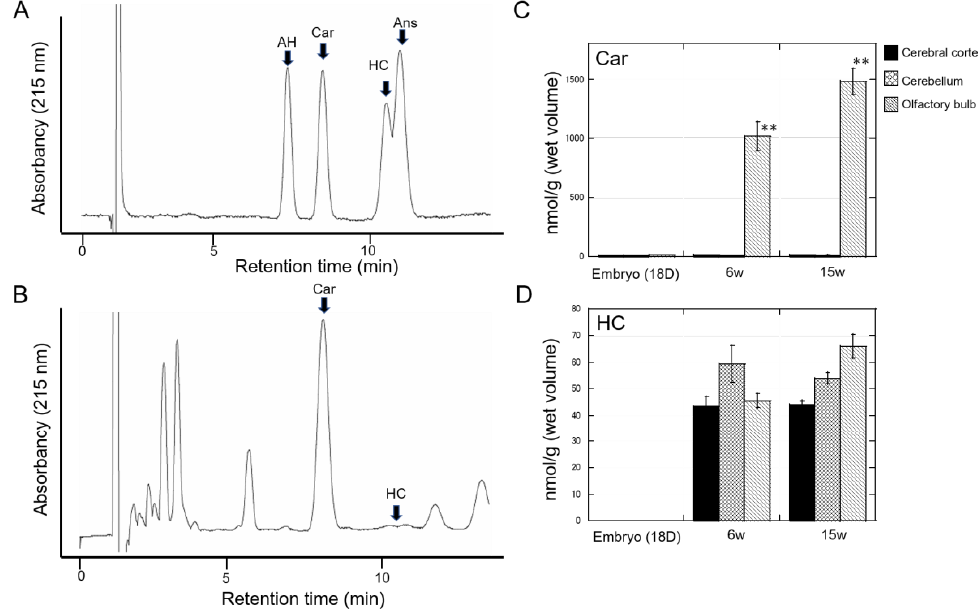
Figure 4. Developmental changes in carnosine and related compounds in the brain. Each brain region (cerebrum, cerebellum, and olfactory bulb) was dissected from Wistar rats, homogenized and heated at 95 °C for 15 min. After centrifugation, the supernatant was analyzed by HPLC equipped with a Hypercarb TM column (Thermo Fisher Science, Waltham, MA, USA). Carnosine (Car), homocarnosine (HC), alanyl histidine (AH), and anserine (Ans) were analyzed using an isocratic elution of 7% acetonitrile in the presence of 0.1% trifluoroacetic acid at a flow rate of 1 mL/min and monitored with UV at 215 nm. Data are expressed as mean ± S.E.M ( n = 4). ( A ) Typical chromatogram of standard solutions. ( B ) Typical chromatogram of the olfactory bulb extract at 15 weeks. ( C ) Developmental changes in carnosine. The amount of carnosine (nmol/g wet tissue) in cerebral cortex, cerebellum, and olfactory bulb at embryo 18 days (E18), and 6 weeks (6 W) and 15 weeks (15 W) postnatal was analyzed by HPLC. Data are expressed as mean ± S.E.M ( n = 4). * p <0.05, ** p <0.01 compared with E18. ( D ) Developmental changes in homocarnosine. The amount of homocarnosine (nmol/g wet tissue) in cerebral cortex, cerebellum, and olfactory bulb at embryo 18 days (E18), and 6 weeks (6 W) and 15 weeks (15 W) postnatal was analyzed by HPLC. Data are expressed as mean ± S.E.M ( n = 4).